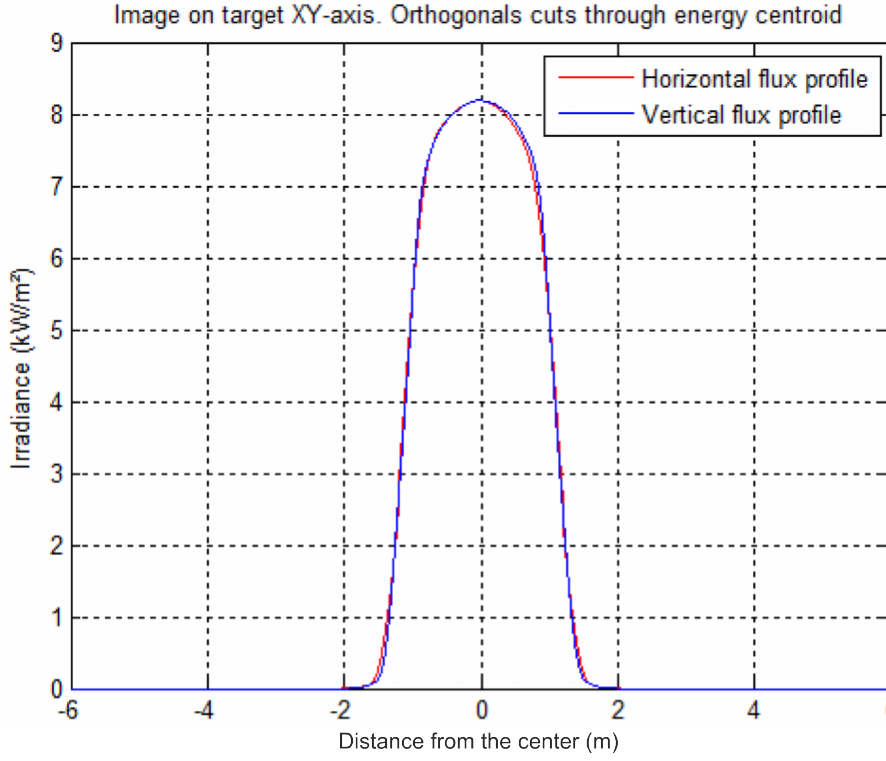
Figure 13. Vertical and horizontal flux profile on the target (10 March 2017 at 11:07